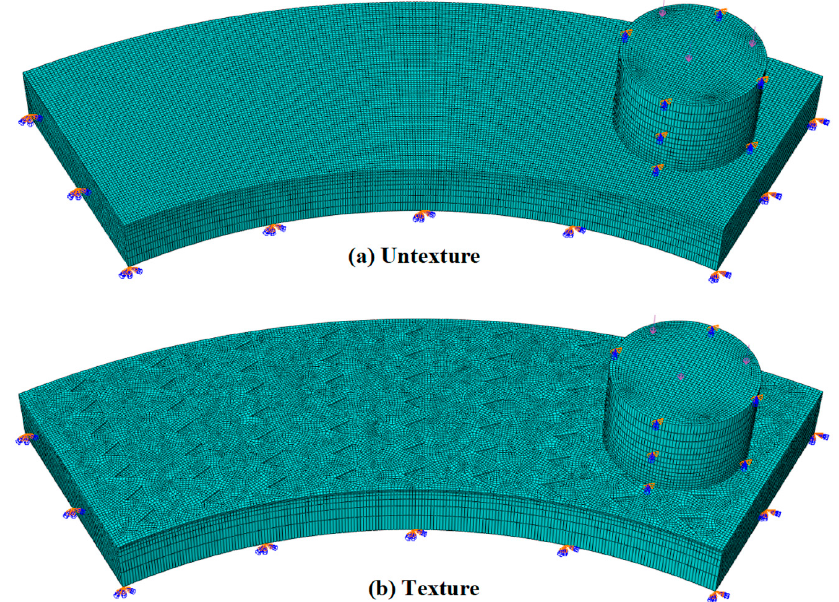
Figure 3. Finite element model mesh. ( a ) Untextured surface. ( b ) Textured surface.